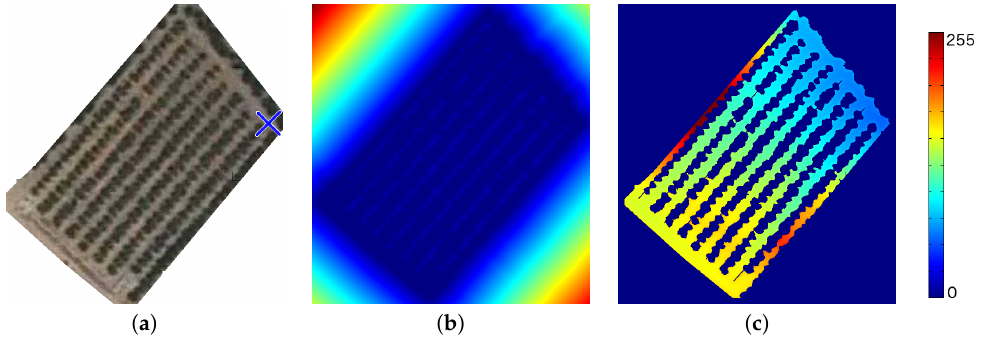
Figure 12. Distance images: ( a ) Parcel satellite image with the final position (blue x-cross), ( b ) a representation of the normalized Distance matrix image, and ( c ) the modified representation.